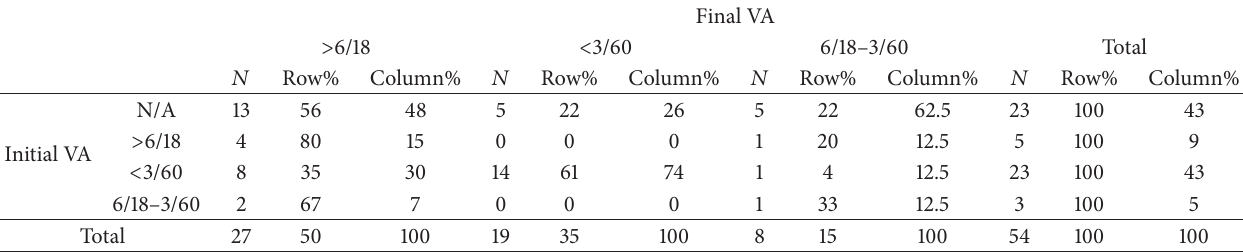
Table 1: Presenting and final visual acuity of children with open globe injuries.